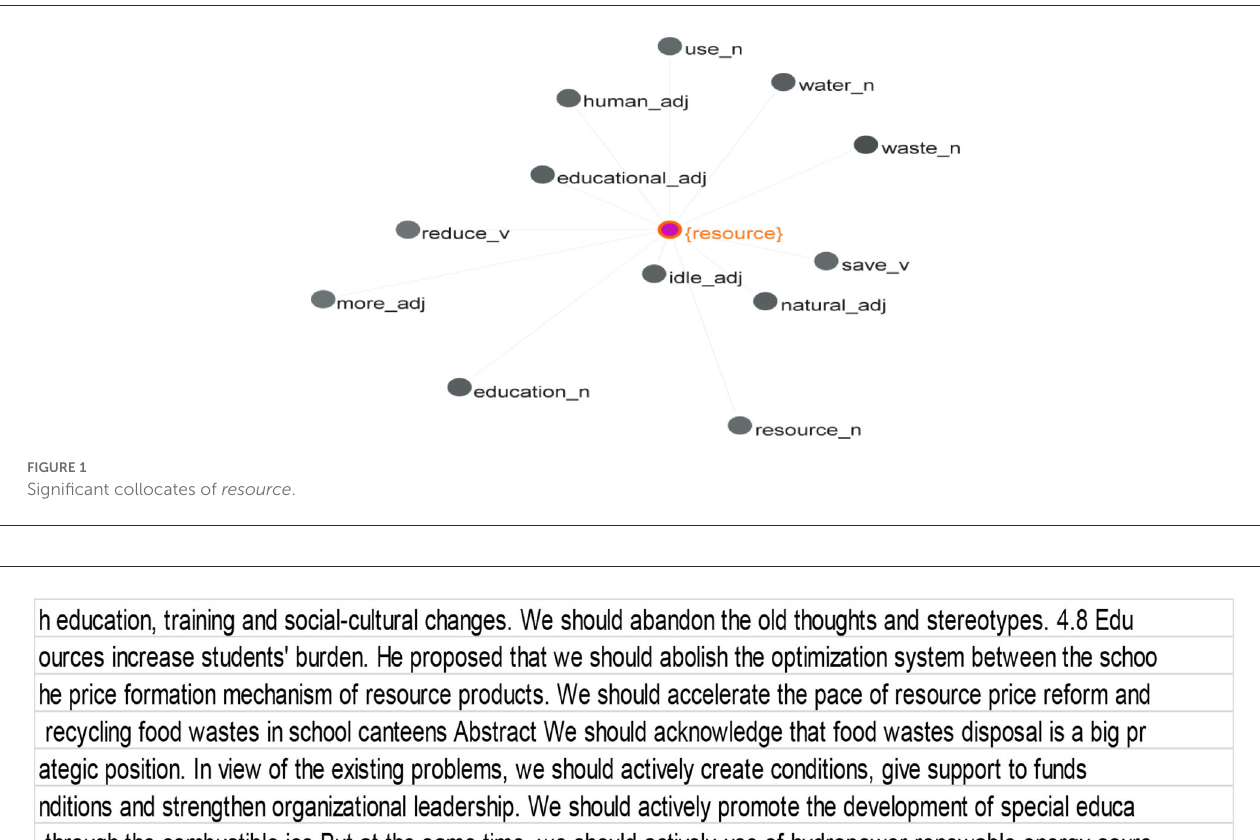
FIGURE2 Extracts from the concordances of we should